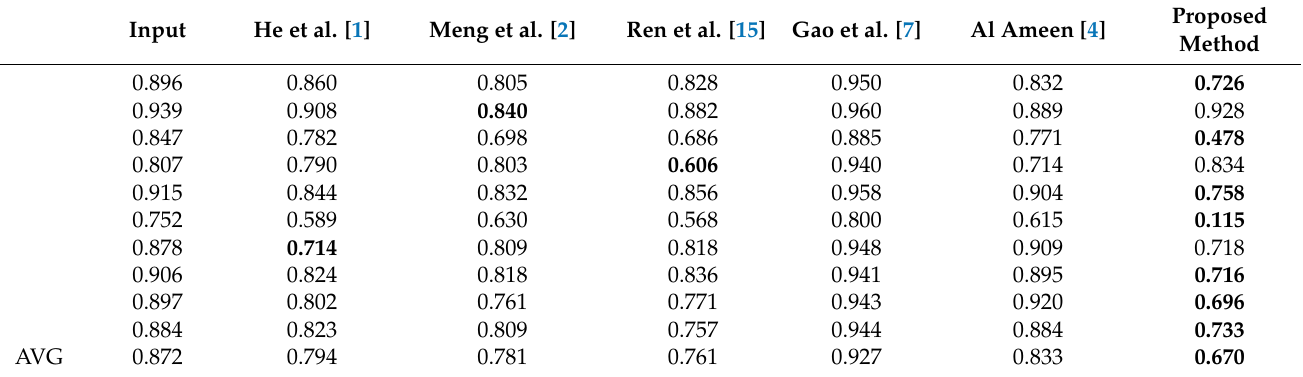
Table 3. The comparison of the HDE [35] scores from Figure 6 (If the score is low, the image is well enhanced. The lowest are indicated in bold